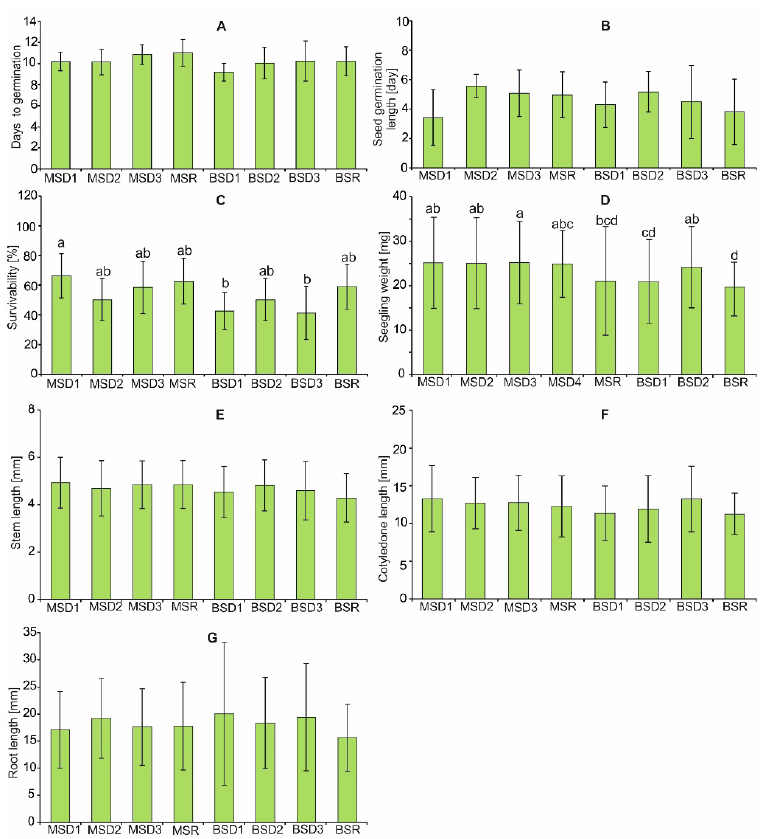
Figure 7. Days to germination, length of germination, and survival ( A – C ) and seedling measure- ments ( D – G ) of the four positions of achenes within the infructescence and the two positions of the infructescence on the plant. MS—main stem; BS—branch stem; D1–D3—achenes produced by disc florets; R—achenes produced by ray florets. Different lowercase letters indicate significant differences according to the U Mann–Whitney test ( p < 0.05).